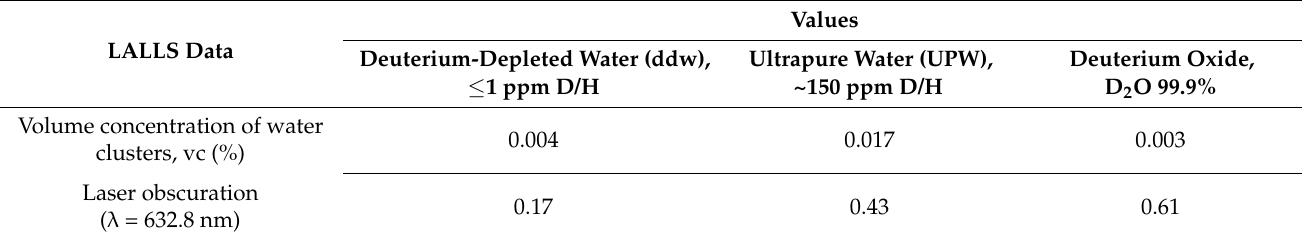
Deuterium Oxide,